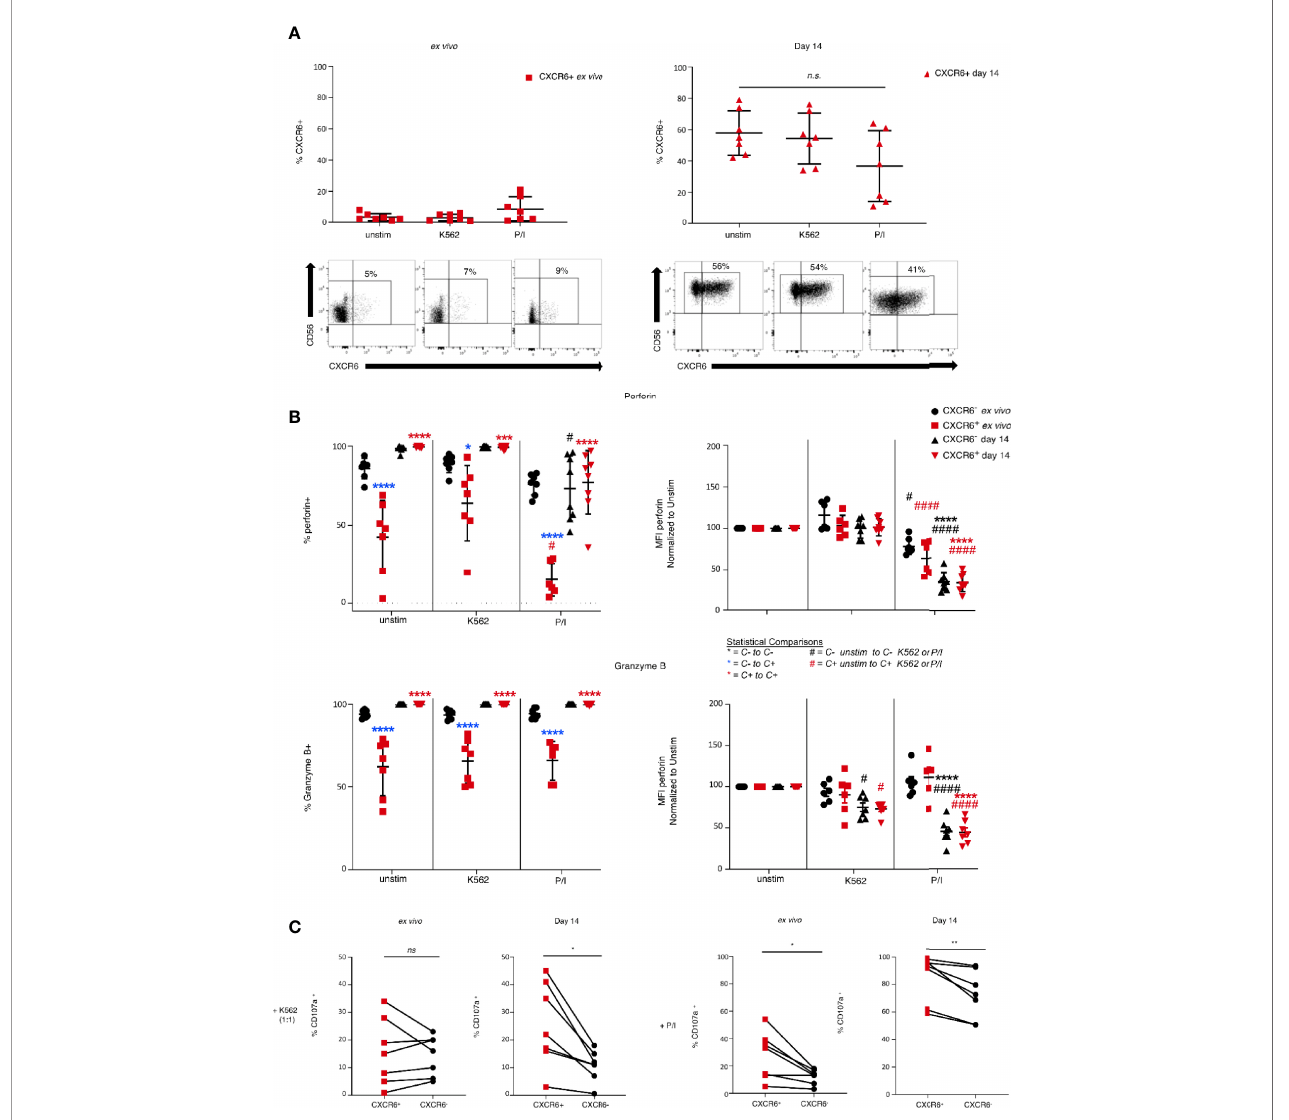
FIGURE 4 | Differences in functional capability between ex vivo and 14 day-activated CXCR6- and + PB-NK cells. Day 0 ( ex vivo ) or day 14 cultured CXCR6- or + PB-NK cells were left unstimulated or stimulated with K562 (1:1) or PMA/ionomycin (P/I) for 4 hours. Multi-parametric fl ow cytometry was performed to determine changes in markers critical for NK cell function. (A) Changes in CXCR6 expression in ex vivo and day 14 cultured CXCR6 + NK cells after exposure to K562 or P/I. Representative fl ow plots are shown below the graphs. A one-way ANOVA with a Dunnett ’ s multiple comparison test was performed. (B) Changes in percent positive and MFI of perforin and granzyme B Ex vivo CXCR6 - NK (black circles); ex vivo CXCR6 + (red squares); day 14 CXCR6 - NK (black triangles); day 14 CXCR6 + NK, red triangles. Statistical comparisons are as designated in the key below. A two-way ANOVA with Tukey ’ s multiple comparison ’ s test was performed. One symbol, p < 0.05; two p < 0.01; three p < 0.001; four, p < 0.0001. (C) Percent CD107a + (degranulating) NK cells in ex vivo and day 14-cultured CXCR6 + and CXCR6 - NK cells. CXCR6 + NK cells from 14-day cultures degranulate signi fi cantly more than CXCR6 – NK cells following stimulation with K562 (p